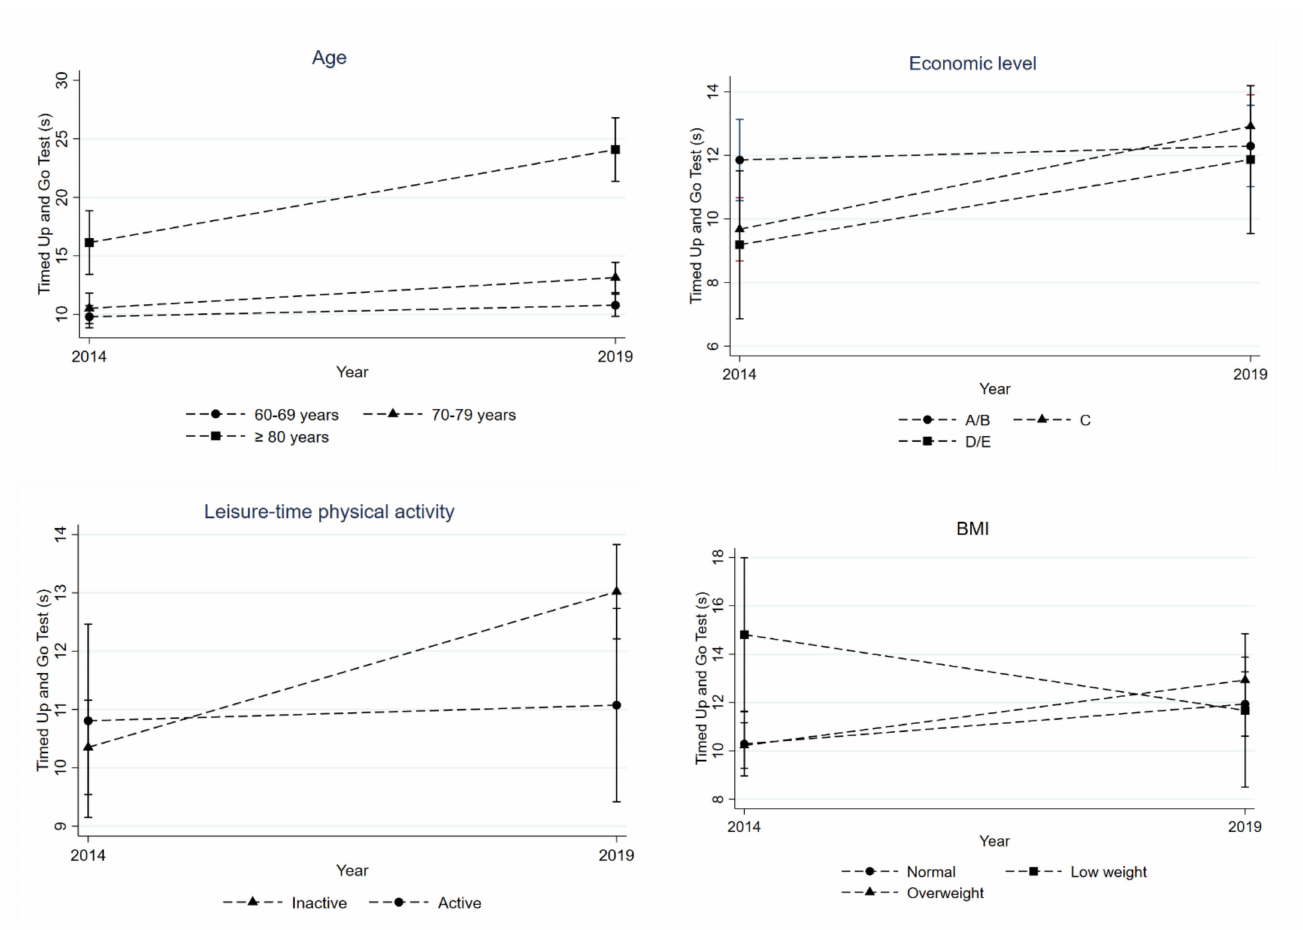
Figure 3. Evolution in terms of TUG time between 2014 and 2019 according to age, economic level, physical activity level, and body mass index